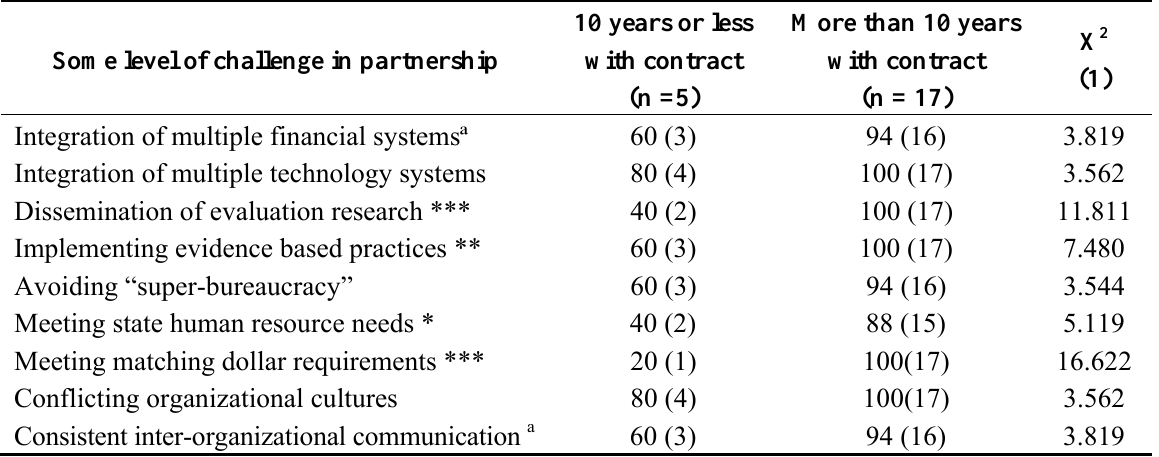
Table 7. Prevalence (%) of agencies reporting some amount of challenge (strongly agree or agree) in partnership by years with contract ( N =